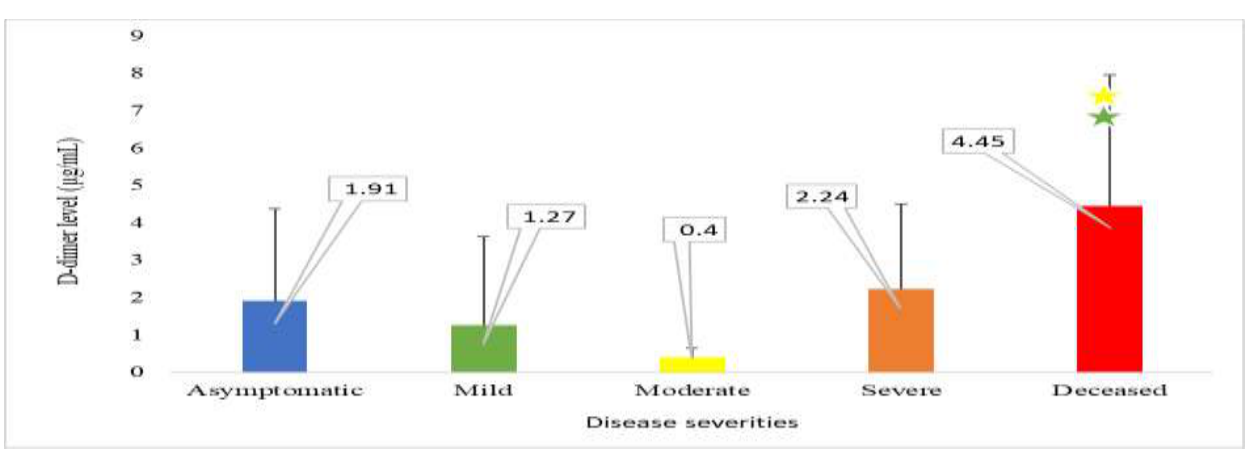
Figure 8: D-dimer levels in 100 patients with COVID-19 of different